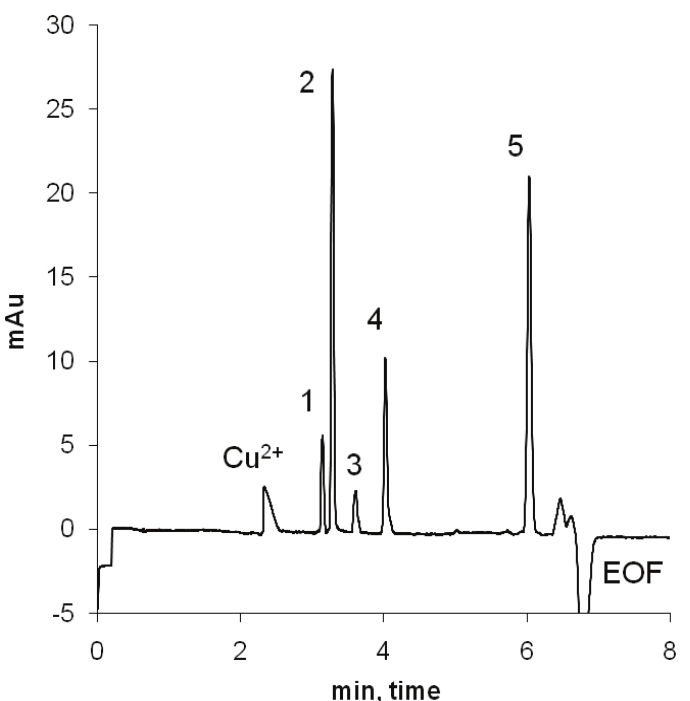
Figure 6. Sample electropherograms of 4-FDC, where (1) ETB, (2) SPFLX–PI, (3) ISO, (4) RIF and (5) PYR. Experimental conditions: electrolyte: 50.0 mmol L −1 HAc/NaAc buffer and 12.5 mmol L −1 CuSO , hydrodynamic injection: 30 mbar. 5 s, voltage: +25 kV, 25ºC cartridge 4 temperature, direct detection at 262 nm; capillary:75 μm × 48.5 cm (40.0 cm effective Fig. 6 , means the migration time of electrosmotic flow, a characteristic phenomenon in capillary electrophoresis [21 ]. In order to show the reliability of the PLS2 method a